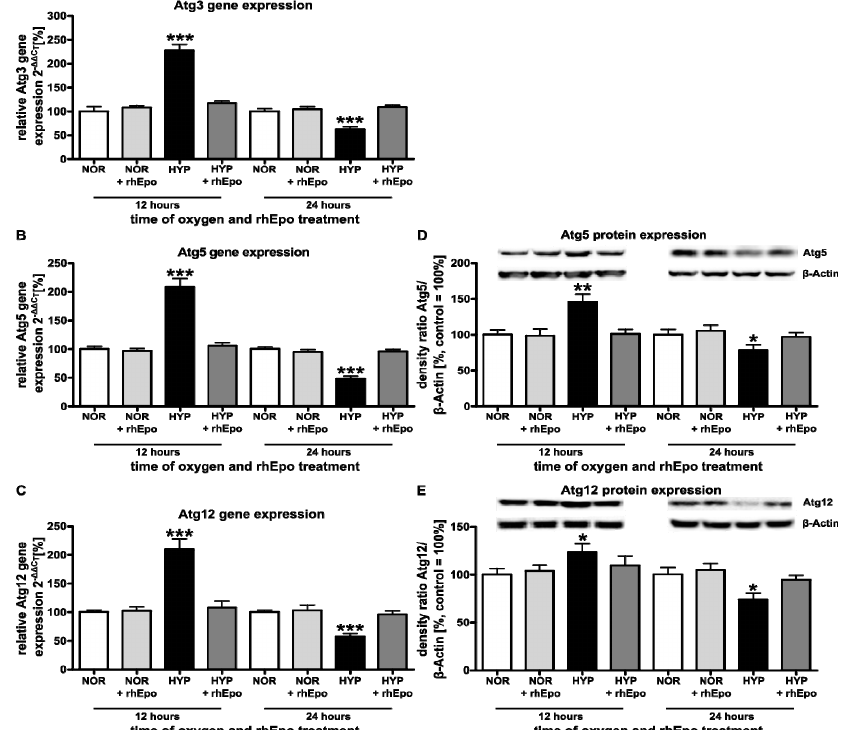
Figure 2. Hyperoxia-triggered alterations of autophagy-related components are modified by rhEpo treatment. ( A – C ) Quantitative analysis of Atg3 , 5 and 12 mRNA expression after 12 h and 24 h of high oxygen concentration with or without rhEpo treatment. ( D , E ) Atg5 and Atg12 protein expression, densitometric data represent the ratio of the pixel intensity of the Atg5 or Atg12-Atg5 complex band to the corresponding β -actin band. White bar normoxic control (NOR); light grey bar normoxic control + rhEpo; black bar hyperoxia (HYP); dark grey bar hyperoxia + rhEpo. Data are normalized to levels of rat pups exposed to normoxia (control 100%; bars represent mean + SEM, n = 8 per group, *** p < 0.001, ** p < 0.01, * p < 0.05, independent t -test after one-way ANOVA, bonferroni corrected compared to respective